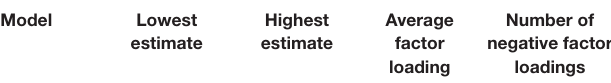
Model 5: Correlated exercises + general performance